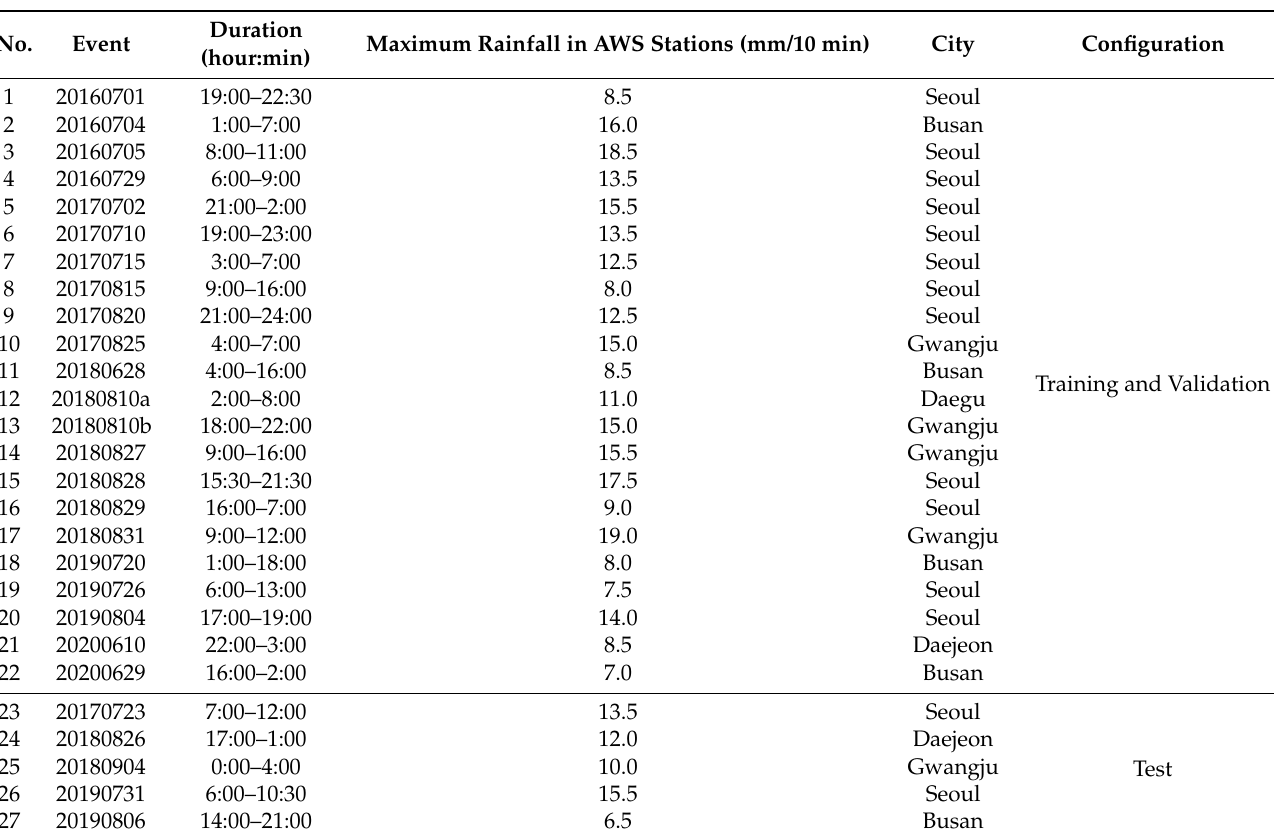
Table 2. The heavy rainfall events used in this